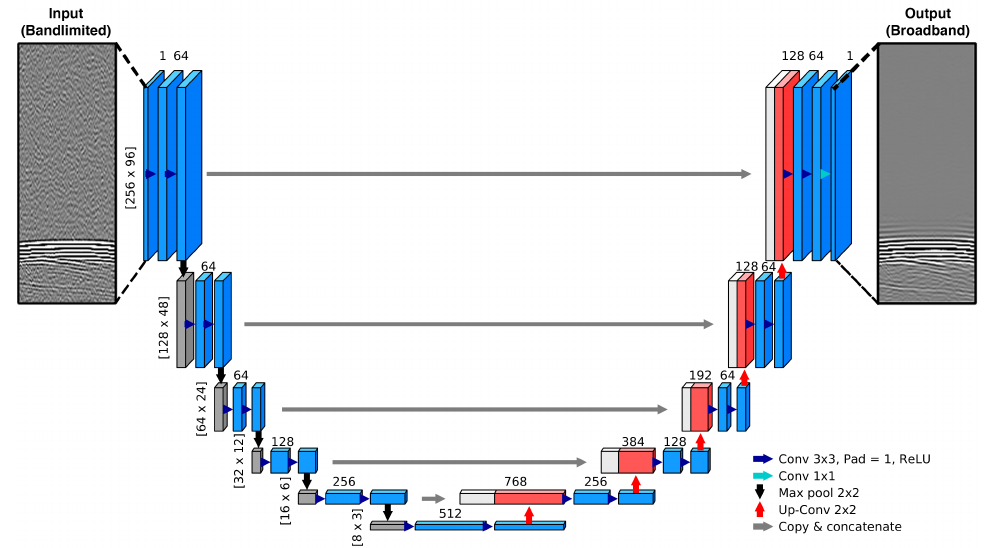
Figure 1. U-net based CNN architecture for extrapolating low-frequency signal content for 2D input samples of ultrasound data. Plotted volumes represent feature maps, with x,y dimensions given at the start of each row, while values above these blocks denote the number of channels. Grey blocks, downsampling steps; red blocks, upsampling steps; white blocks, corresponding feature maps that were copied over from the contracting